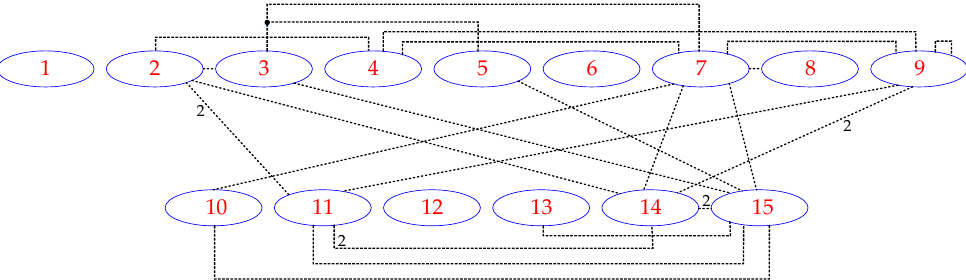
Figure 4. Installation locations of the tie switches in the NDSU 881 test case.